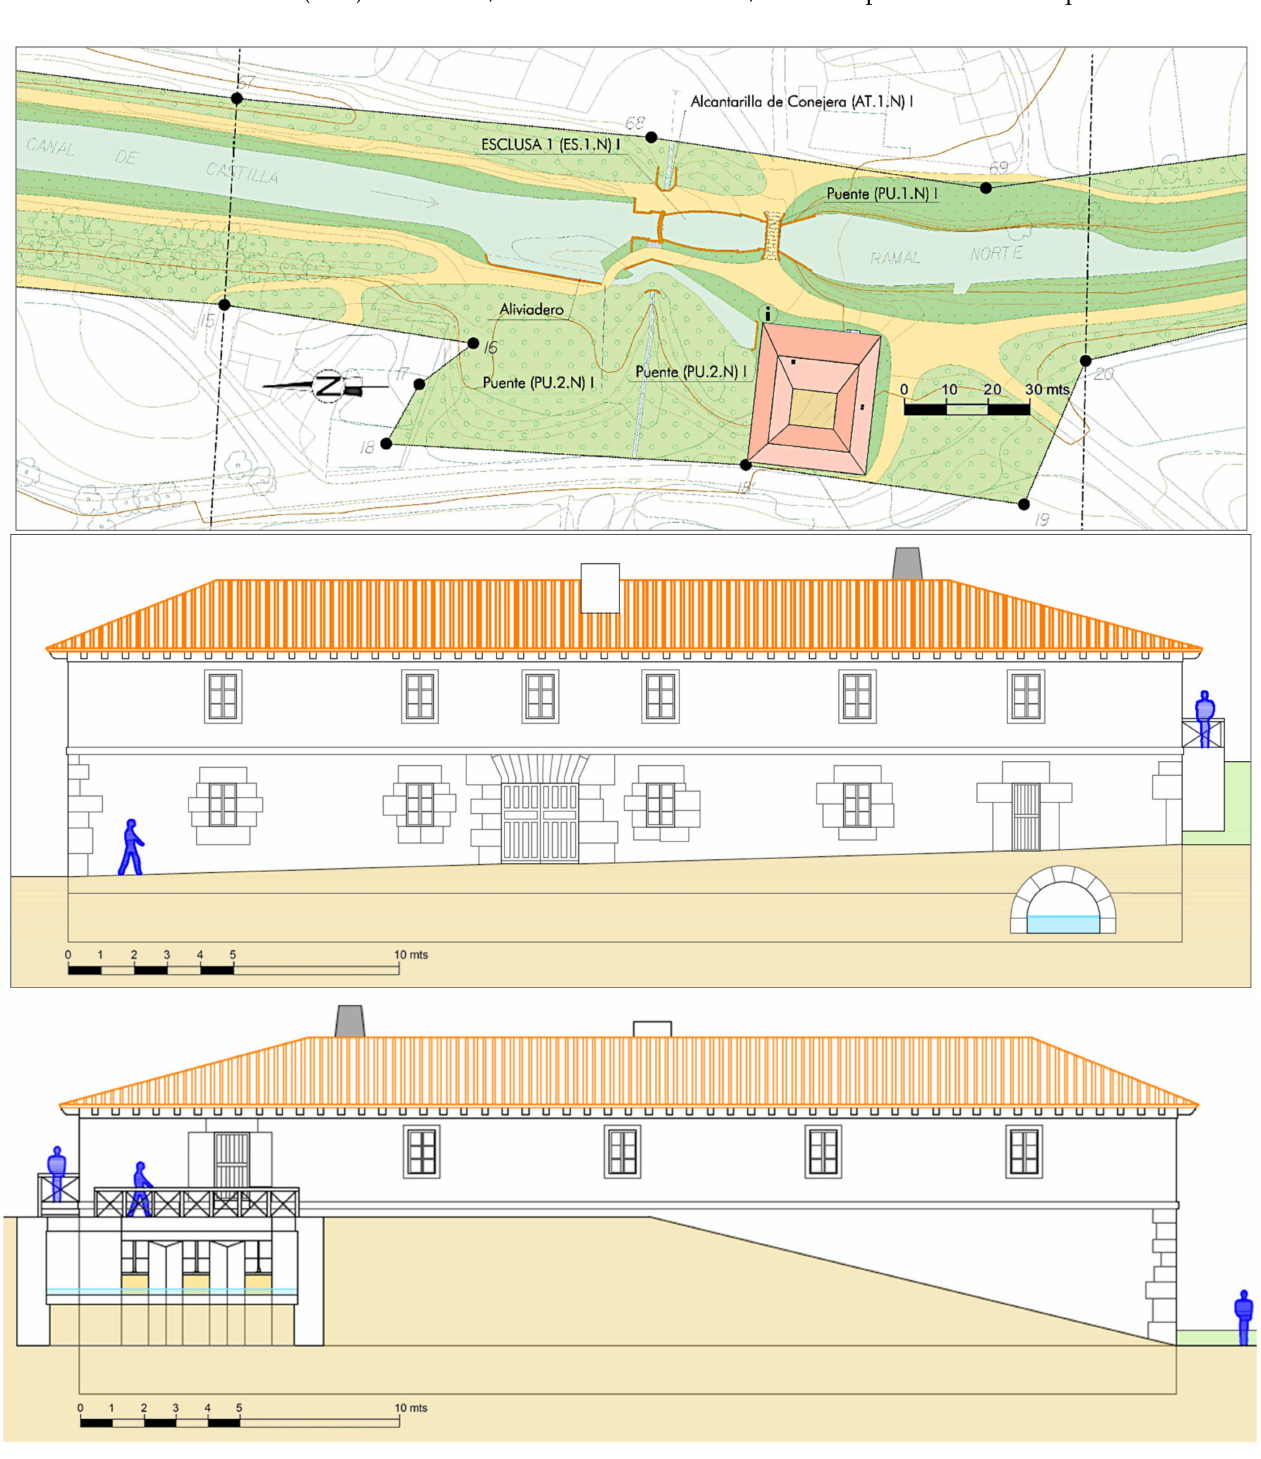
Figure 10. Location plan of the artefact and main facades (south and north). Source: own